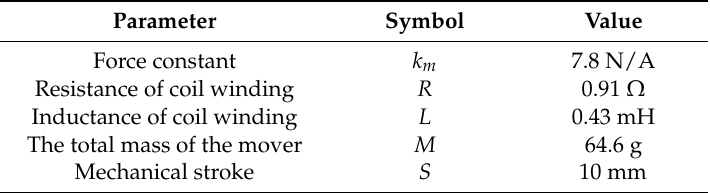
Table 2. The structural parameters of the electromagnetic actuator. Parameter